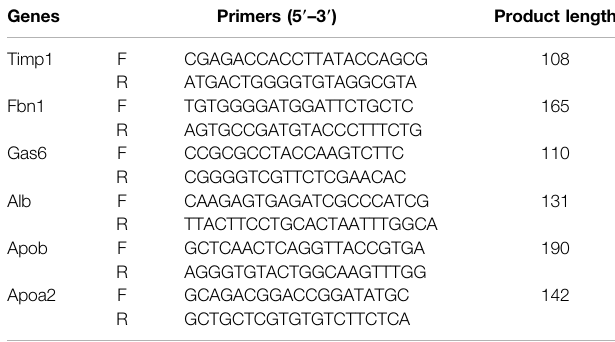
Frontiers in Pharmacology |